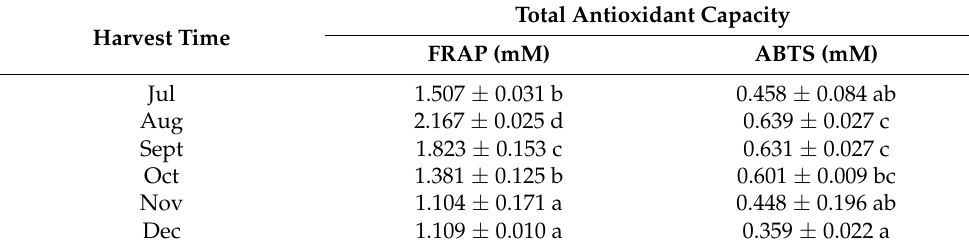
Table 1. Evaluation of total antioxidant capacity of PCR in different harvest periods. The measurement results of FRAP method and ABTS method are expressed in FeSO 4 • 7H 2 O and Trolox equivalent, respectively, and the unit is mM. Different letters indicate significant differences between the total antioxidant capacity of PCR of each month. The same letter indicates no significant difference between the total antioxidant capacity of PCR of these months. Total Antioxidant Capacity Harvest Time FRAP (mM) ABTS (mM)